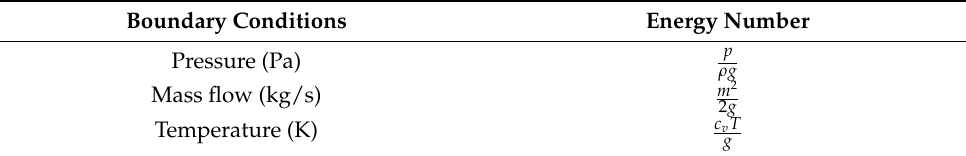
Table 3. The energy number of different